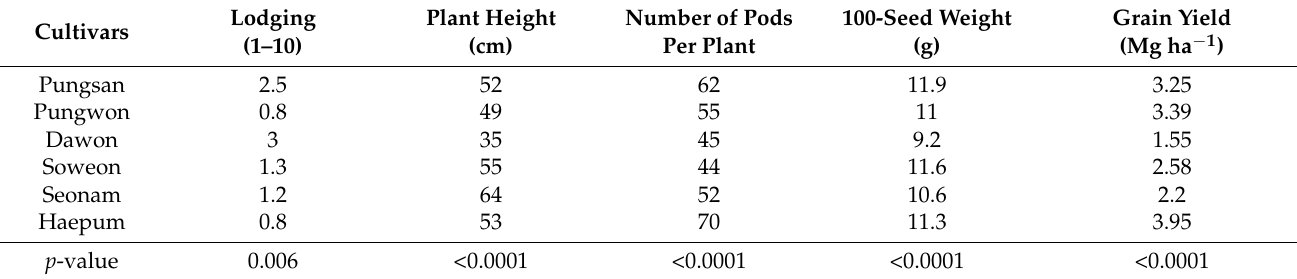
Table 5. Lodging, plant height, number of pods per plant, 100-seed weight, and grain yields for all six soybean sprout cultivars in Korea (Lodging rate ranged from 0 (no lodging) to 10 (severe lodging)).